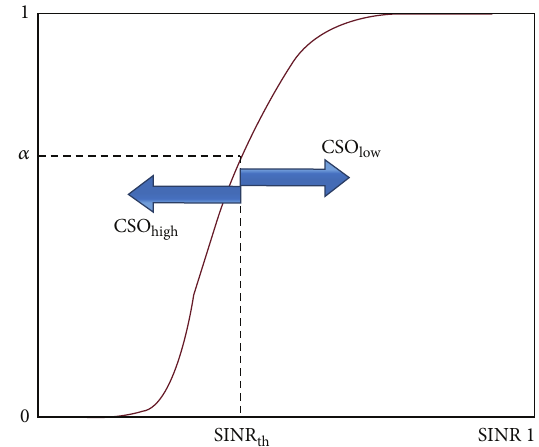
Figure 10: CDF of SINR adopted to decide on CSO [10].